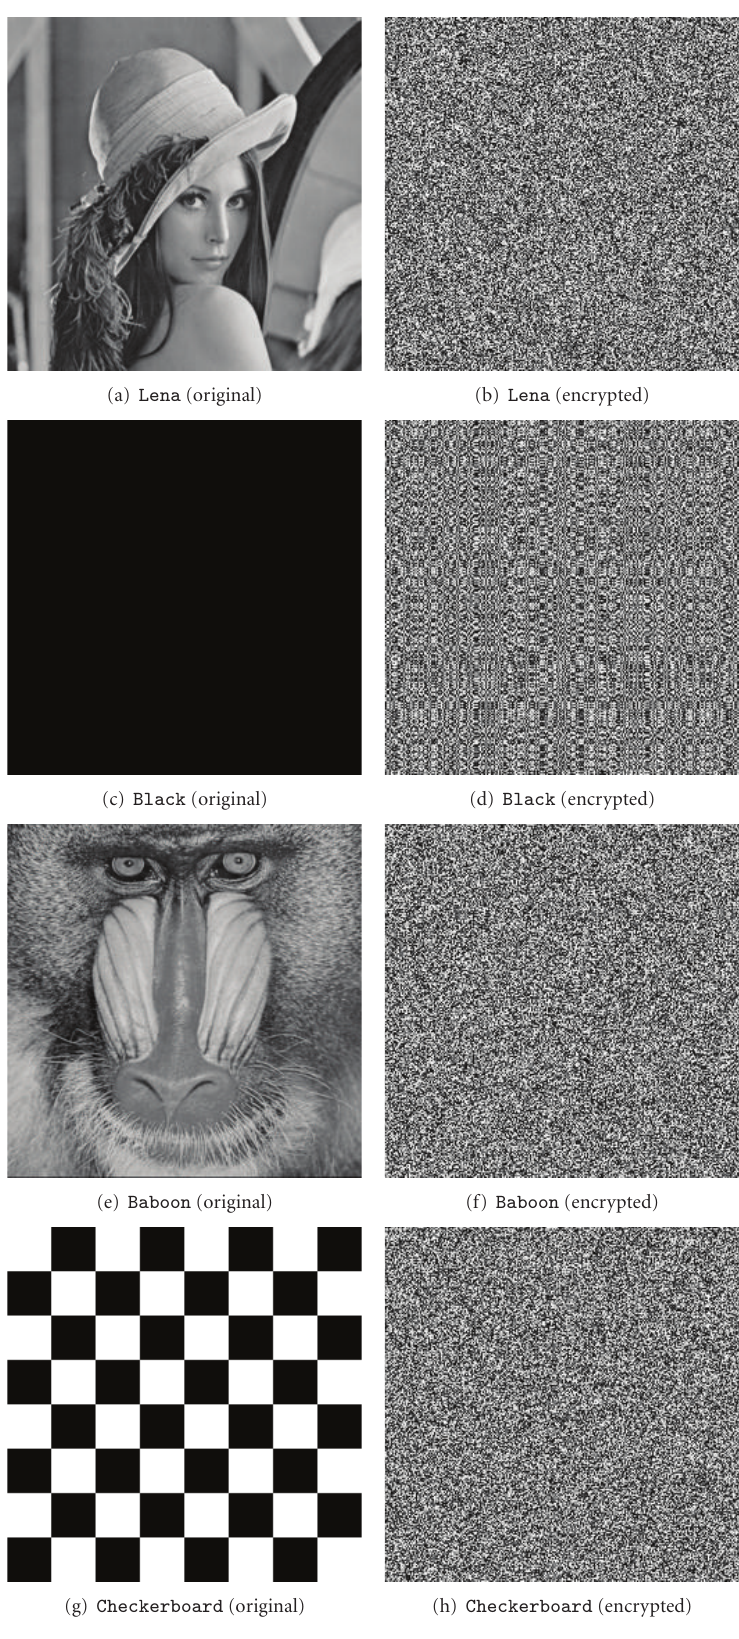
Figure 1: Original and encrypted